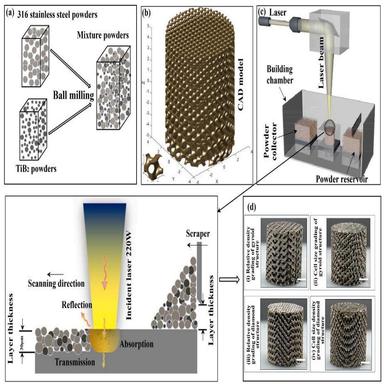
Schematic diagram of fabricating TPMS structures; (a) mixing stainless-steel and TiB2 nanoparticles, (b) generating CAD model, (c) SLM process and (d) different types of TPMS structures: (i) relative density grading of gyroid, (ii) cell size grading of gyroid, (iii) relative density grading of diamond and (iv) cell size grading of diamond.